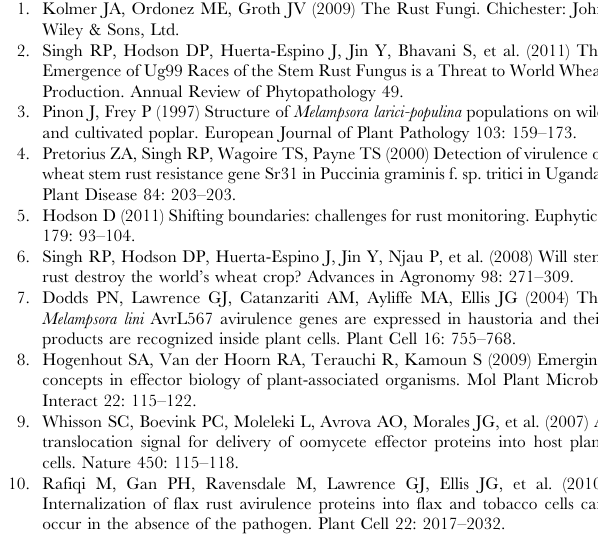
Figure S1 Analysis of genome architecture used to define the threshold for long FIR genes. (A) Distribution of P. graminis f. sp. tritici and M. larici-populina genes according to the length of their FIRs. Genes were sorted into two-dimensional data bins for each genome and number of genes is shown by a colour code. Crosses indicate median value for the two genomes combined; dotted circles are given as a reference to compare the two genomes; arrows point toward areas of the graph illustrating an overall expansion of M. larici-populina intergenic regions compared to P. graminis f. sp. tritici . (B) Same diagrams as in A showing the ratio of the frequency of secretome genes in a bin compared to frequency in the whole genome. Genes with FIRs less than , 800 bp tend to be depleted in secretome genes (green dotted line) whereas genes with at least one FIR longer than , 10 Kb tended to be enriched in secretome genes (purple dotted line). (C) Distribution of secretome tribes according to their content in secreted proteins (Y-axis) and in proteins encoded by genes with at least one FIR longer than 10 Kb (X-axis). Size of bubbles corresponds to size of the tribes. Table S1 Typical secreted enzyme PFAM domains enriched in the secretome of rust fungi. Table providing enrichment fold, p-value of a chi-squared test for enrichment in secretome, number of total and secreted proteins and list of tribes containing the PFAM